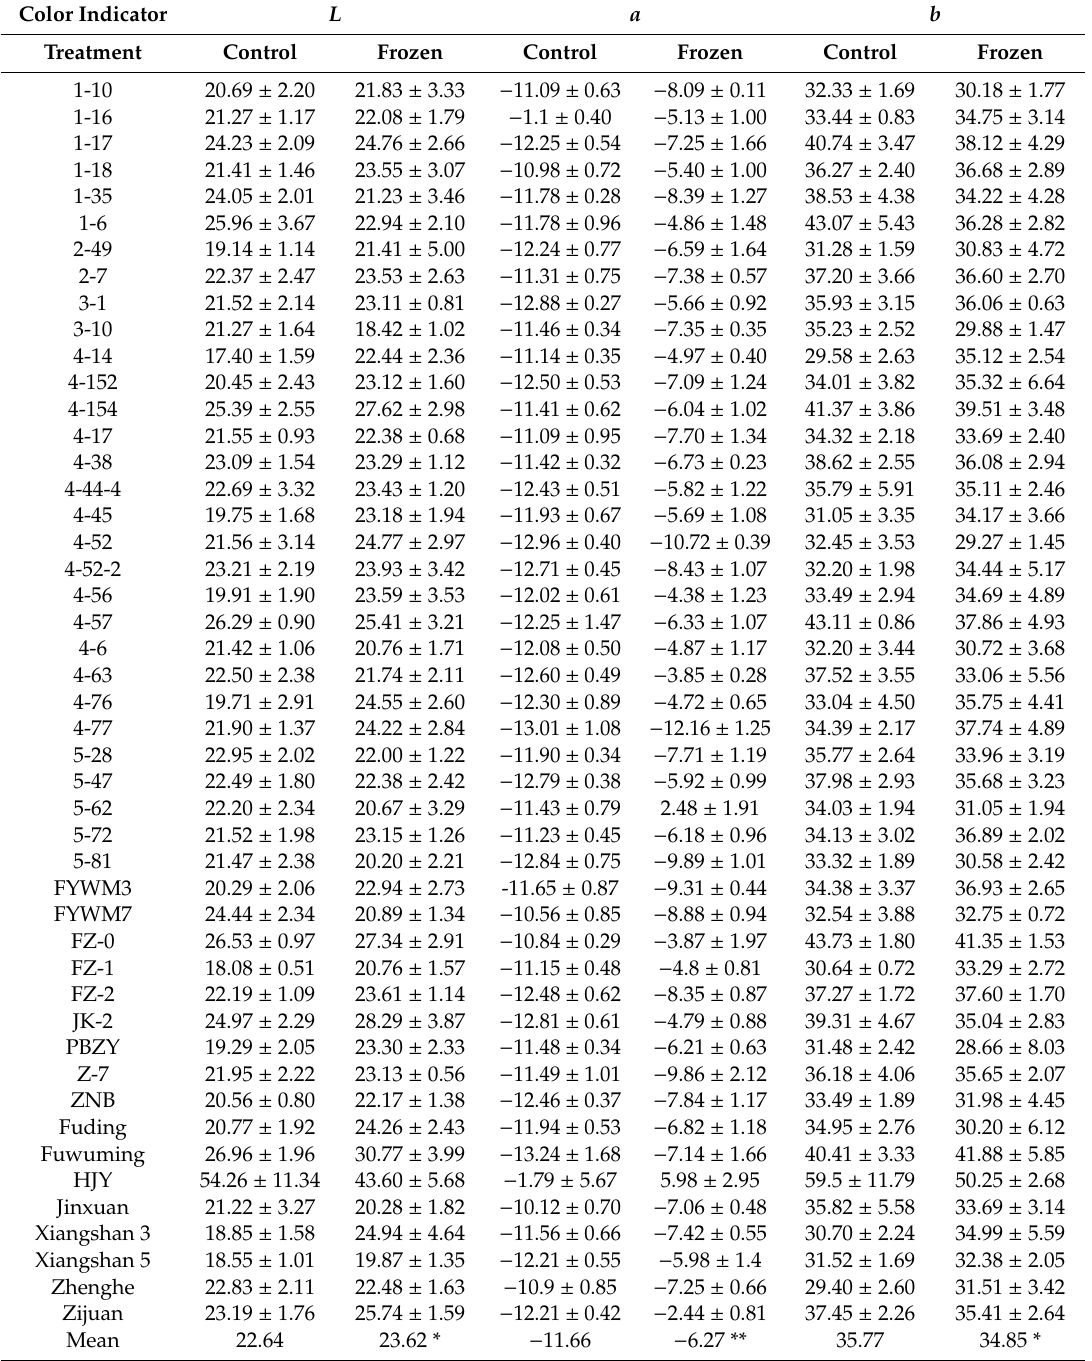
Table 3. E ff ects of freezing on indicators of Hunter color